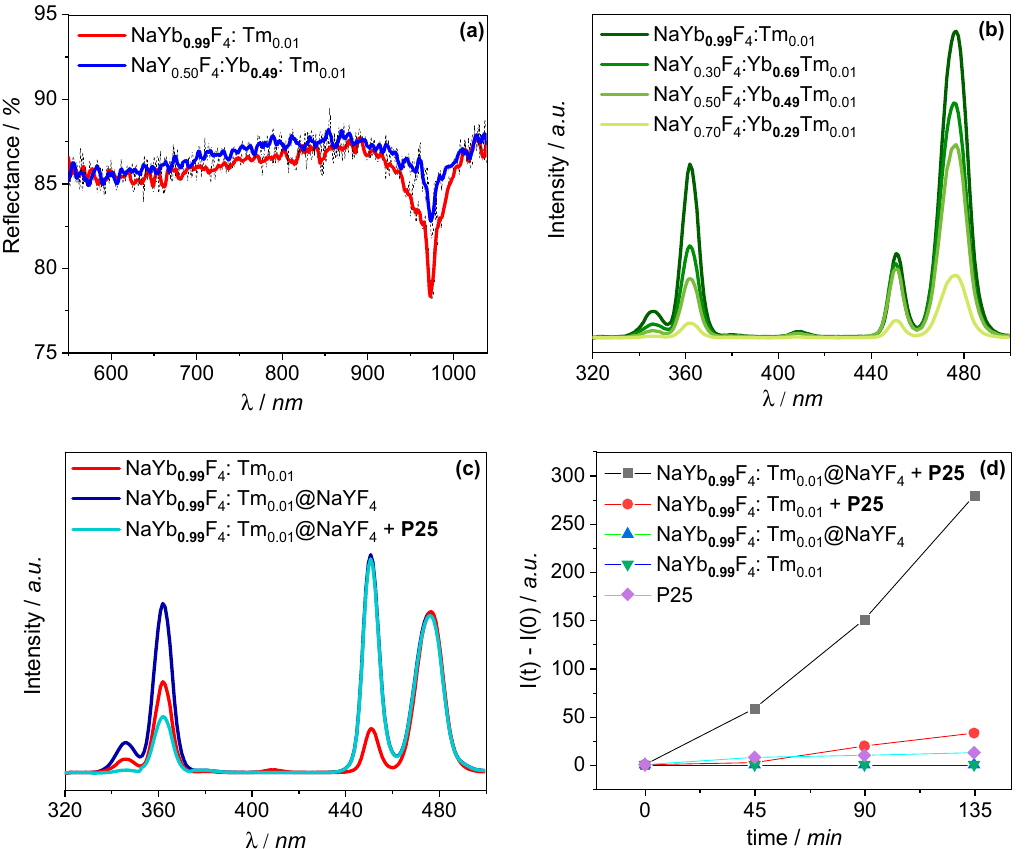
Figure 5. ( a ) Diffuse reflectance spectra of chosen upconverting particles (UCPs). ( b ) Upconversion luminescence spectra of NaYF 4 crystals doped with different amounts of Yb 3+ ions (29%, 49%, 69%, and 99%), under 980 nm NIR excitation. ( c ) Upconversion emission spectra of the core, core-shell particles, and a mixture of the core-shell particles with P25. All spectra have been normalized to the same emission intensity at 476 nm. ( d ) Luminescence intensities of hydroxyterephthalic acid generated in the presence of the studied materials irradiated at 980 nm ( λ ex = 315 nm, λ em = 425 nm).